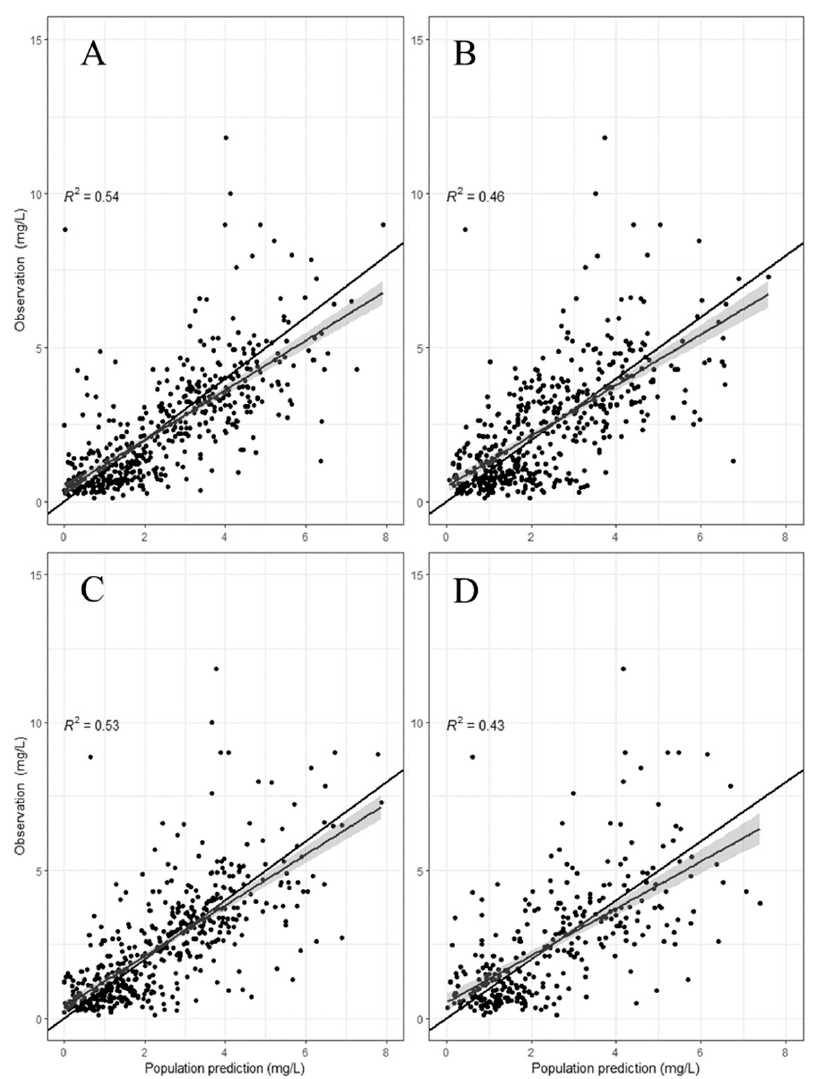
Figure 1. Population-predicted concentration versus observed concentrations for gentamicin models following re-estimation. ( A ) Bos et al. [14], ( B ) Hodiamont et al. [15], ( C ) Rea et al. [13], ( D ) Hodiamont et al. [16]. Black line with shaded area represents the trendline from the scatter points.